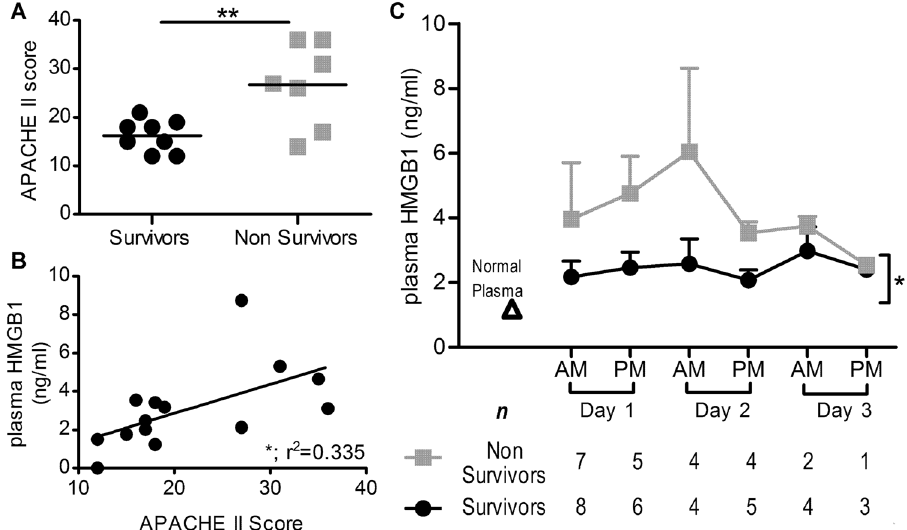
Figure 1. Plasma HMGB1 concentrations and disease severity and mortality in patients with septic shock. Plasma samples from ICU patients with diagnoses consistent with septic shock were taken twice daily (morning and afternoon) for the length of ICU stay. ( A ) APACHE II scores in survivors and non-survivors were compared via two-tailed t test. ( B ) HMGB1 was quantified in patient samples by ELISA and regression analyses